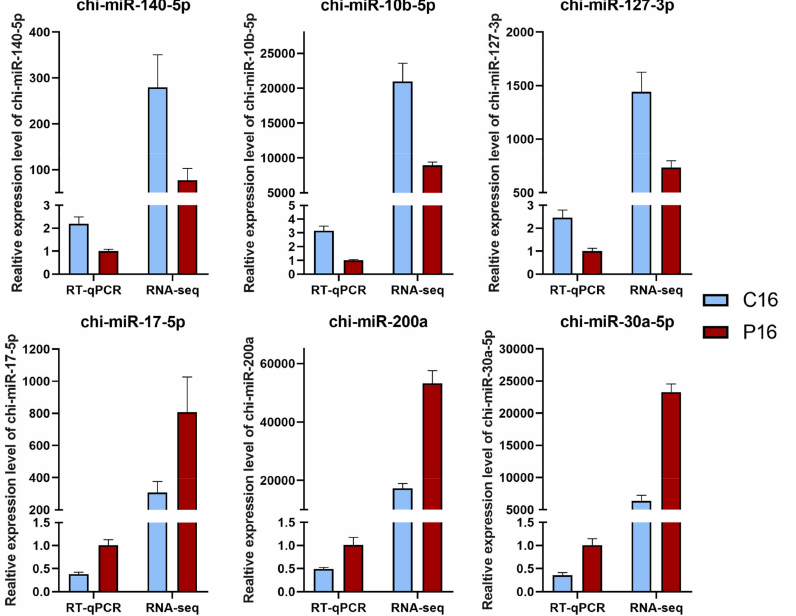
Figure 4. Validation of the expression level of miRNAs. The randomly selected DEMs were verified by RT-qPCR and the results showed was consistent with the RNA-seq data. Data are presented as mean ± SEM values ( n =